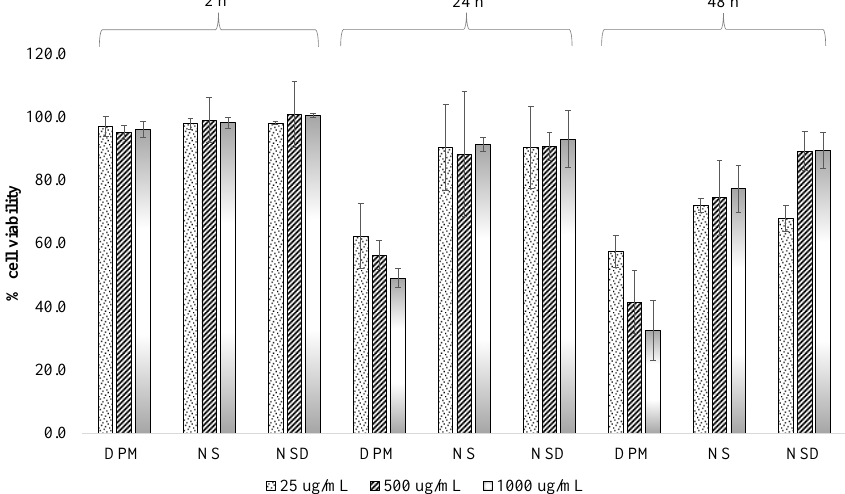
Figure 4. Cell viability (%) of DPM, NS and NSD at different concentrations in Caco-2 cells at three incubation times 2 h, 24 h and 48 h. Values are represented as a mean ± standard deviation.